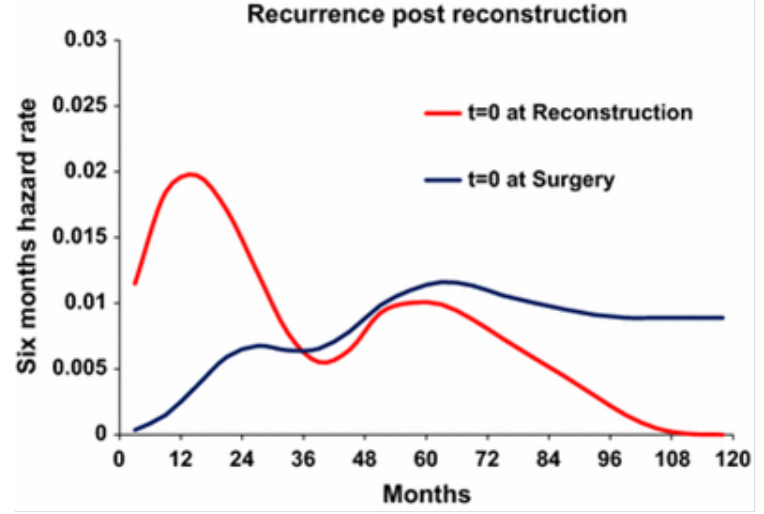
Figure 1. Recurrence pattern for the reconstructed patients ( n = 312) with T = 0 set at reconstruction ( red line ) and at primary surgery ( blue line ). X -axis represents time in months. Y -axis represents six-month hazard rate. This figure is taken from Dillekås, Demicheli, Ardoino, Jensen, Biganzoli, and Straume. The recurrence pattern following delayed breast reconstruction after mastectomy for breast cancer suggests a systemic effect of surgery on occult dormant micrometastases [10].